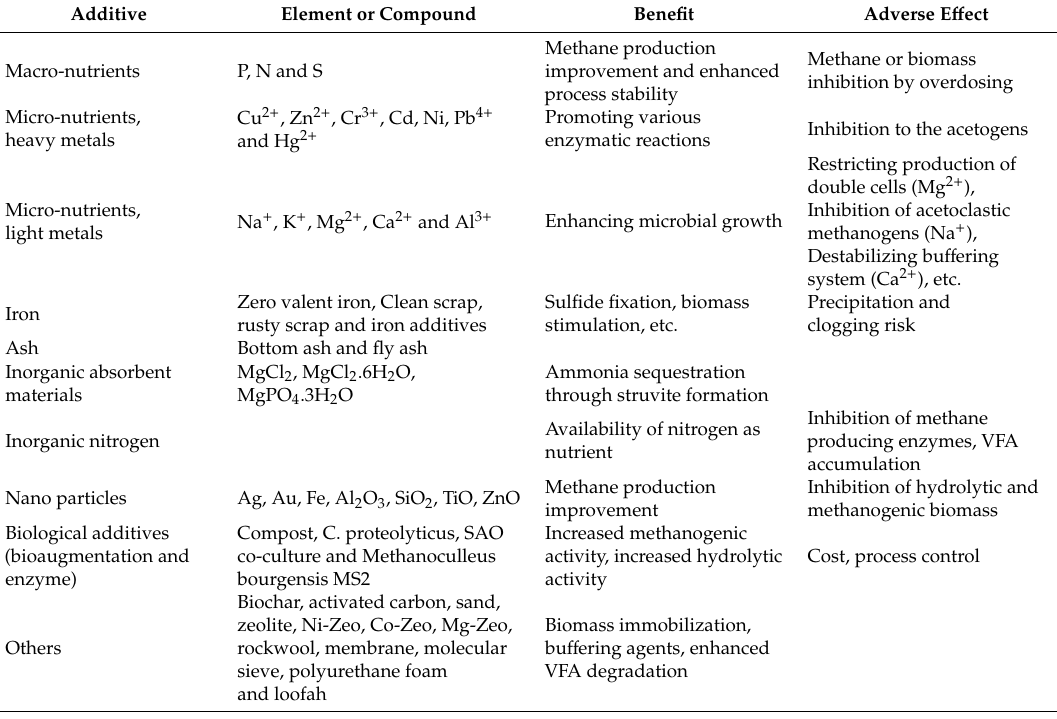
Table 3. The advantages and disadvantages of using additives in AD